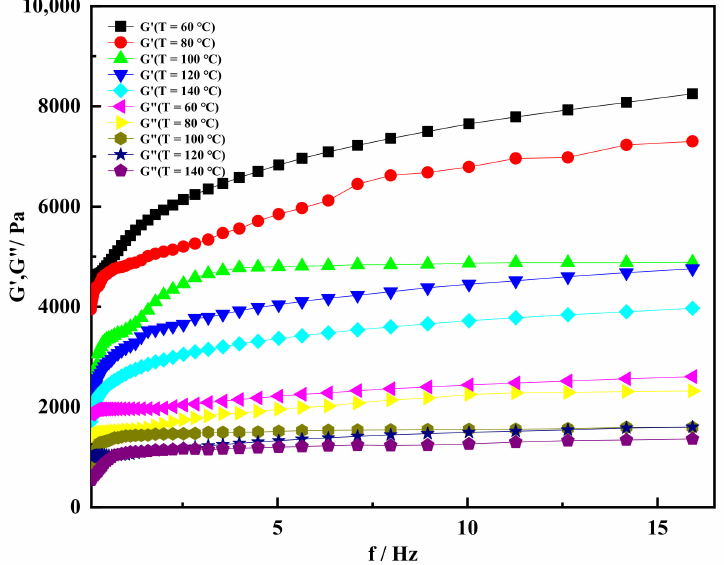
Figure 8. Storage modulus and loss modulus varied with scanning frequency under different temperature